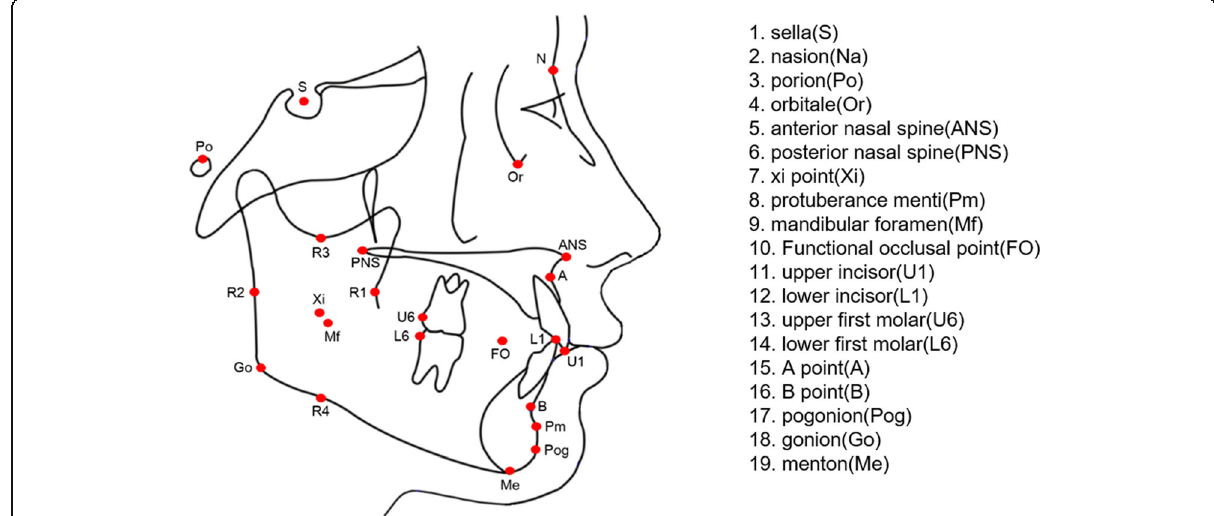
Fig. 1 Landmarks and reference lines used for the cephalometric analysis